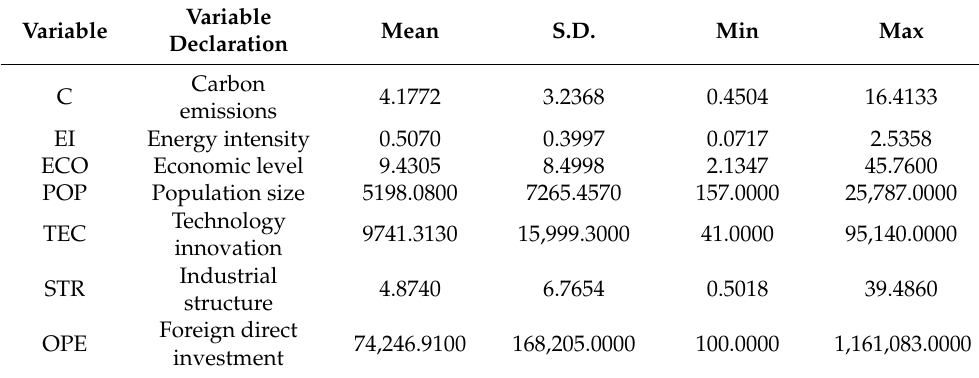
Table 2. Statistical description of the